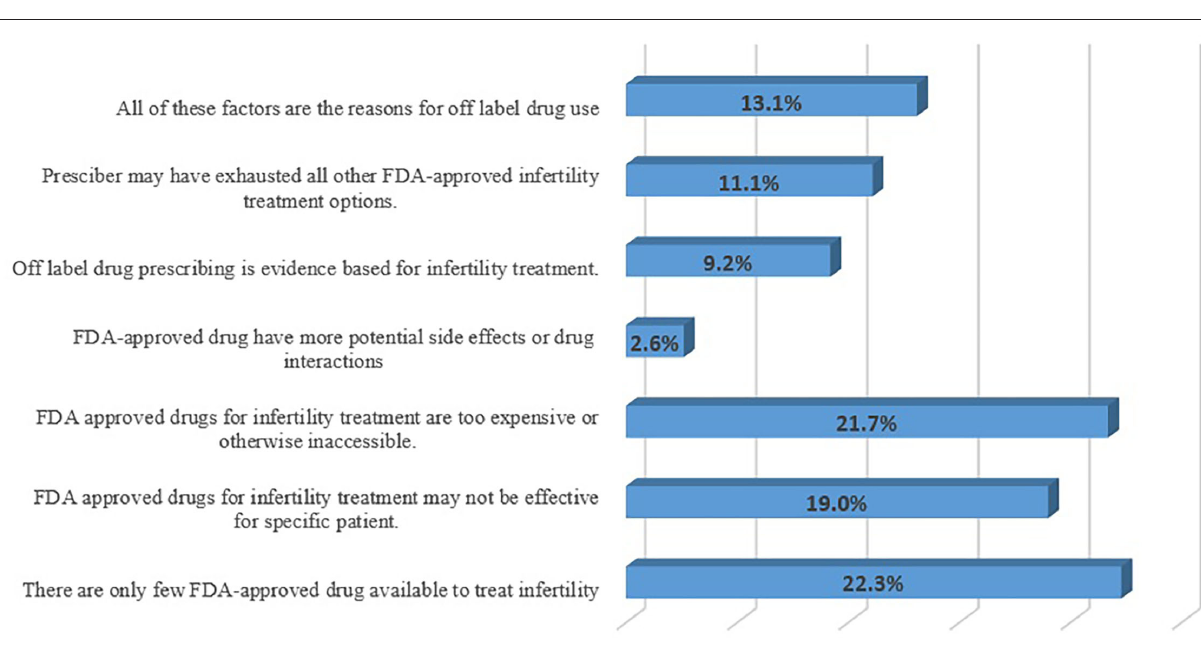
FIGURE 2 | Respondents’ perceived major reasons for increased use of